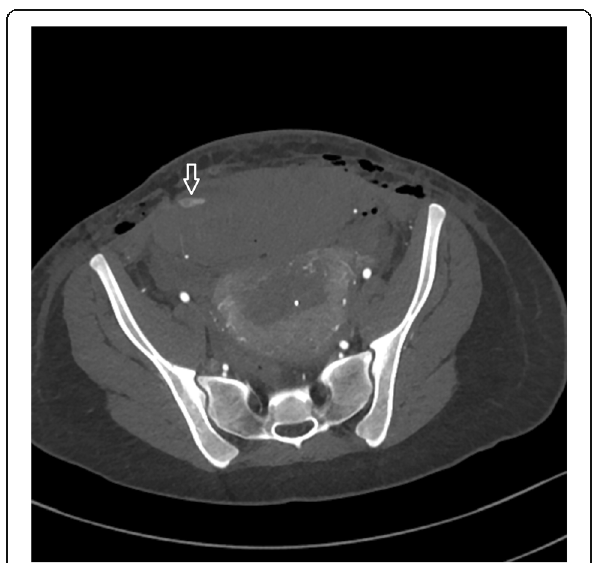
Fig. 9 Case of a 16 year old patient status post cesarean section with decreasing hematocrit and hypotension. No signs of vaginal bleeding on exam. CT with active extravasation in the region of the right inferior epigastric artery with large rectus hematoma (arrow)